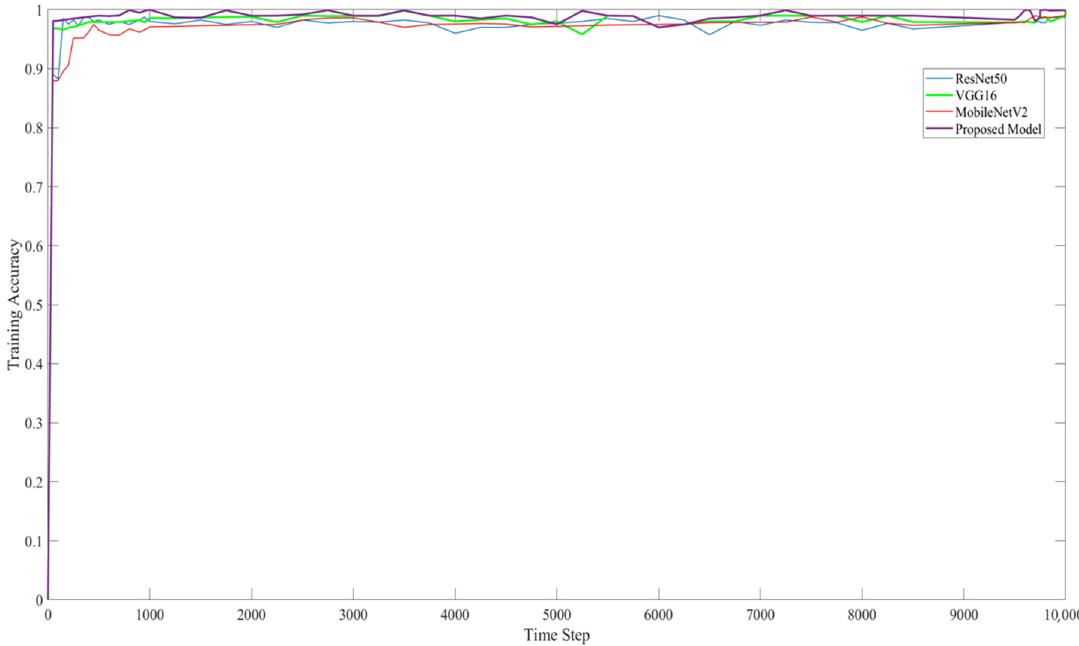
Figure 15. Training accuracy of ResNet50, VG16, MobileNetV2, and the proposed model on image classification.